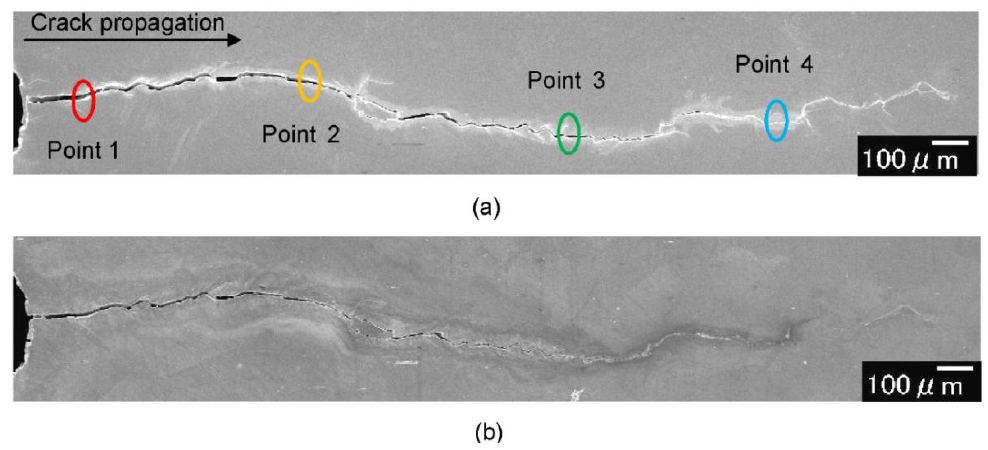
Figure 5. Fatigue crack closure in Sample A induced by high-density electropulsing: ( a ) before; ( b ) after 8; ( c ) after 25; and ( d ) after 35 applications of